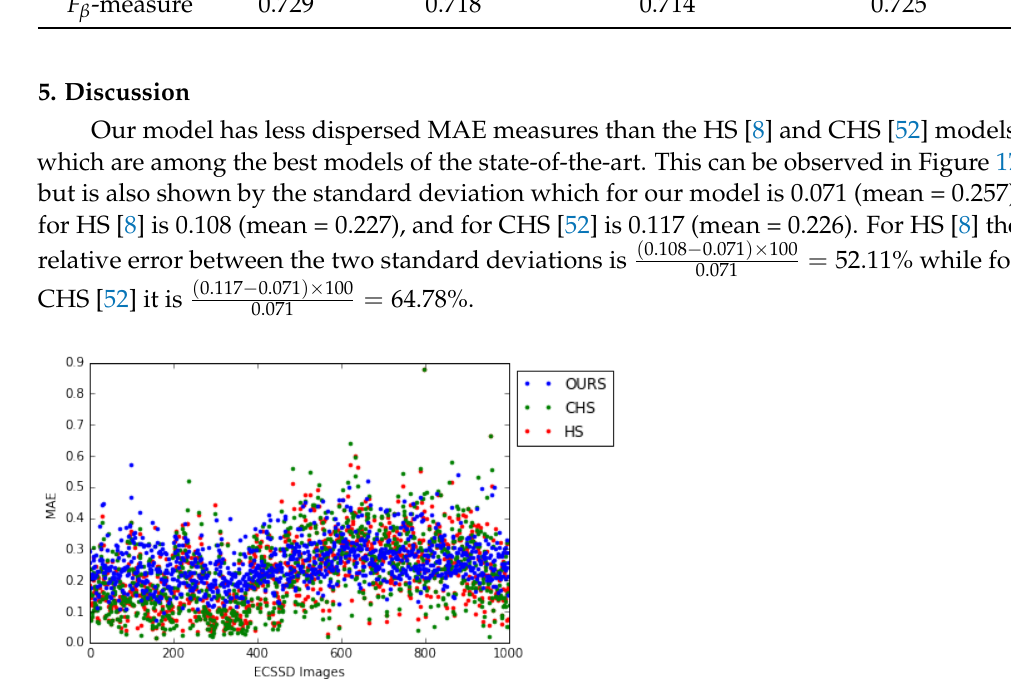
Figure 17. Comparison of the MAE measure dispersion for our model and the HS [8], CHS [52] models on the ECSSD dataset (for MAE, the smaller value is the